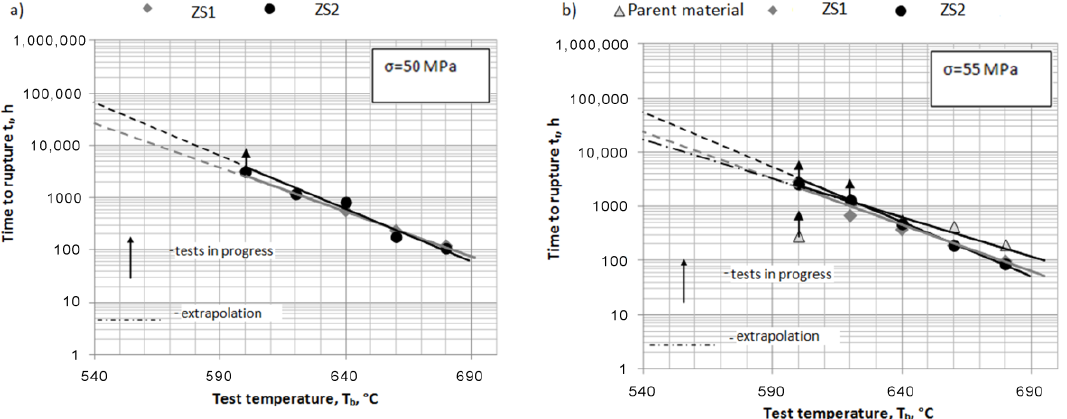
Figure 6. Result of abridged creep tests on the examined ZS1 and ZS2 repair joints and parent material in the form of log t re = f ( T b ) for the adopted stress level of further service ( a ) b = 50 MPa; ( b ) b = 55 MPa Table 5. Results of abridged creep tests.